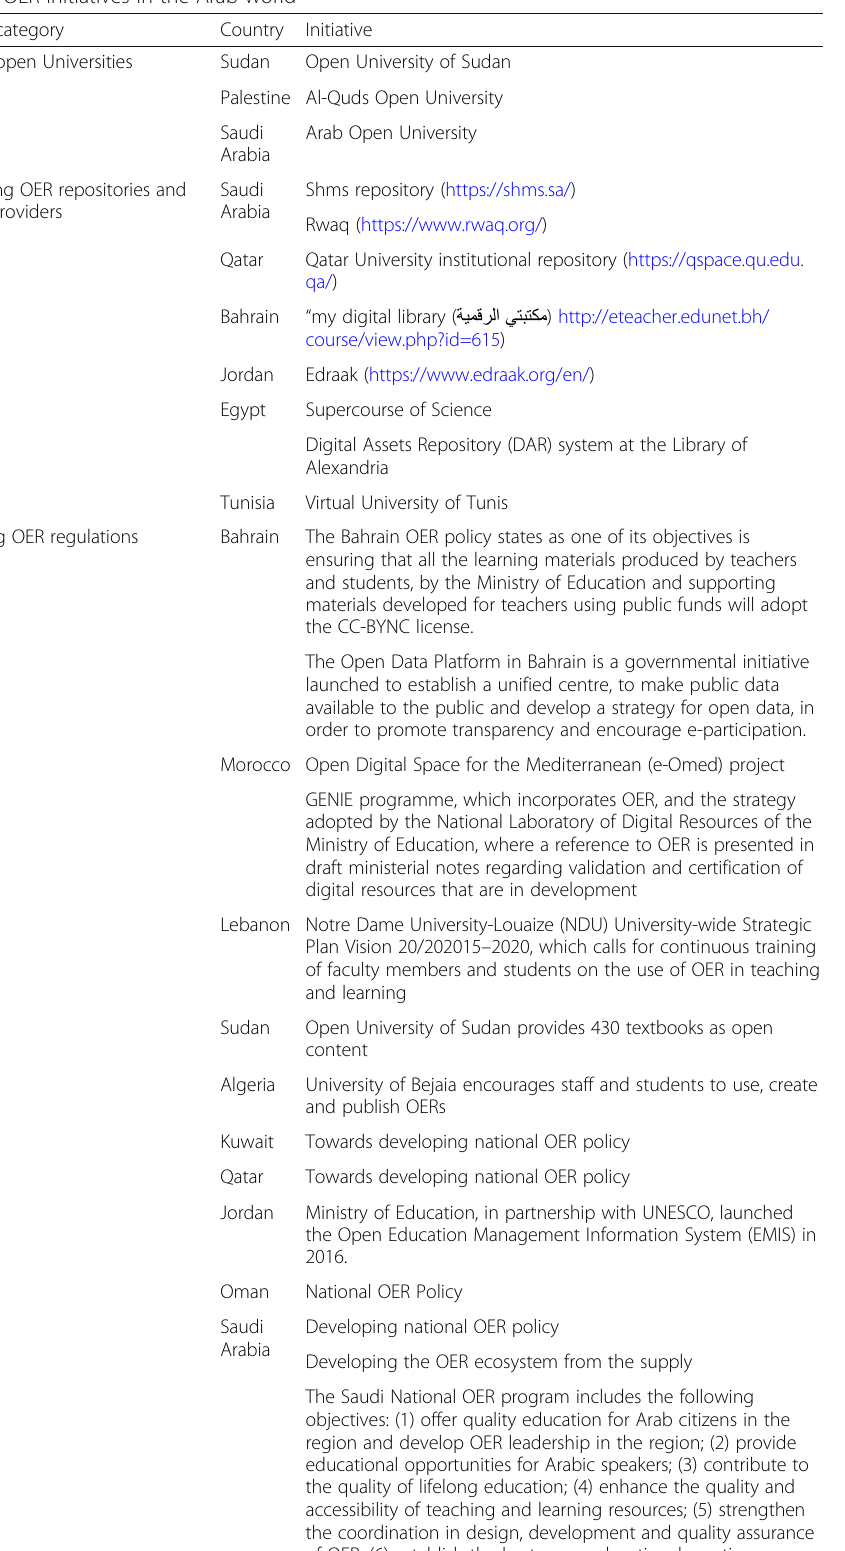
Table 2 OER initiatives in the Arab world Initiative